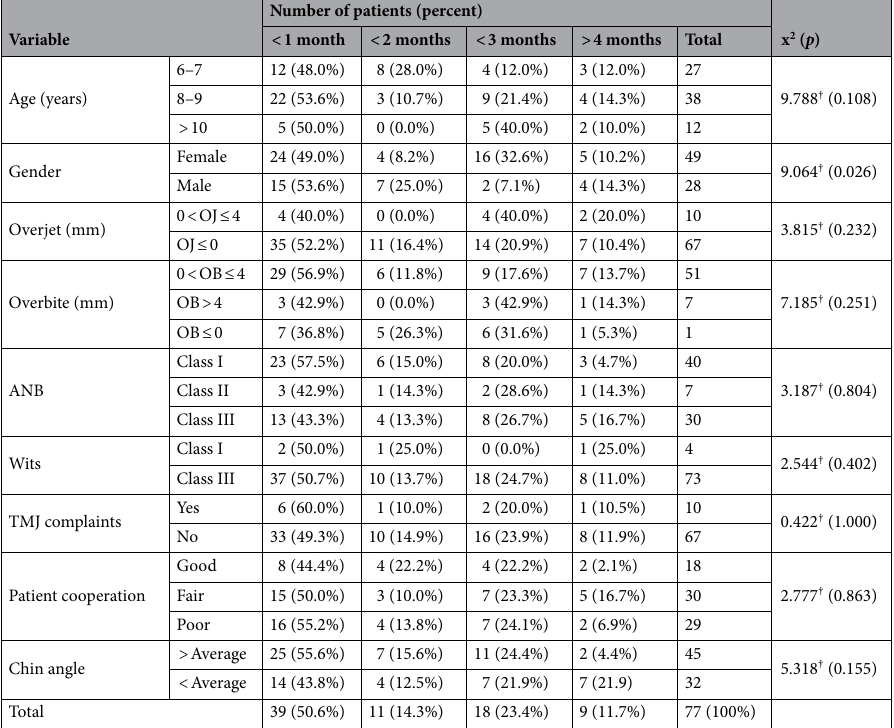
Table 4. The proportion of patients with skin irritation by onset time according to the variables. * p < .05. † Fisher’s exact test.